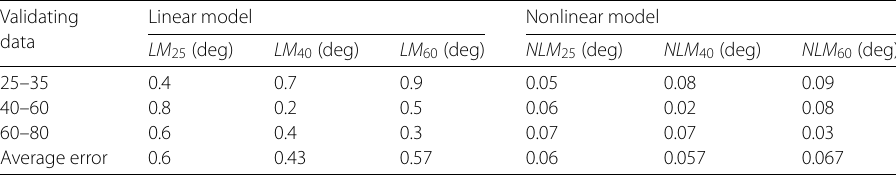
Table 2 Error comparison of the linear and nonlinear models without delay for the yaw responses Validating data